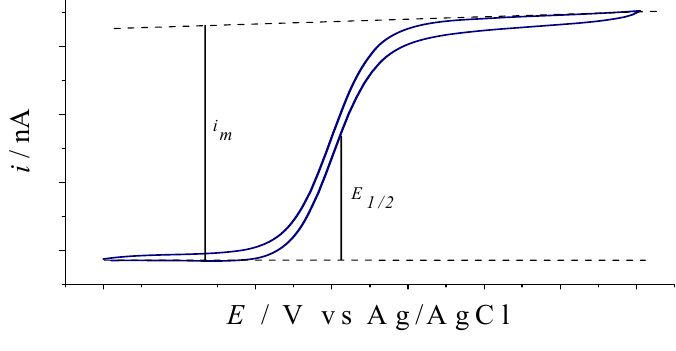
Figure 2. Scheme of the diffusion regimes of an analyte toward the surface of, a) inlaid, b) recessed